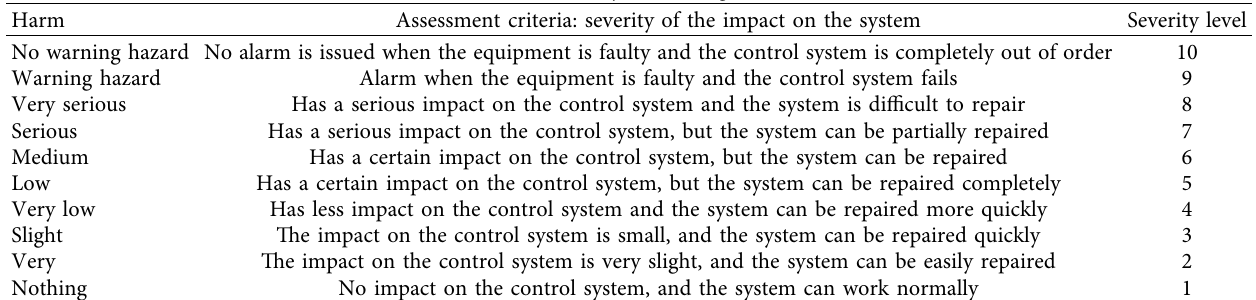
Table 11: Severity ( S ) scoring criteria.